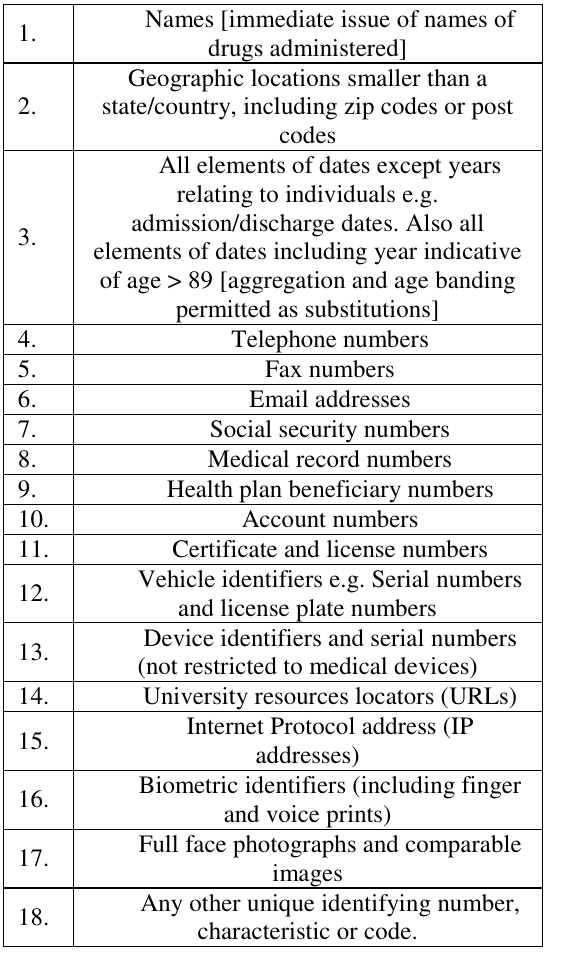
TABLE 1: HIPPA SAFE HARBOUR